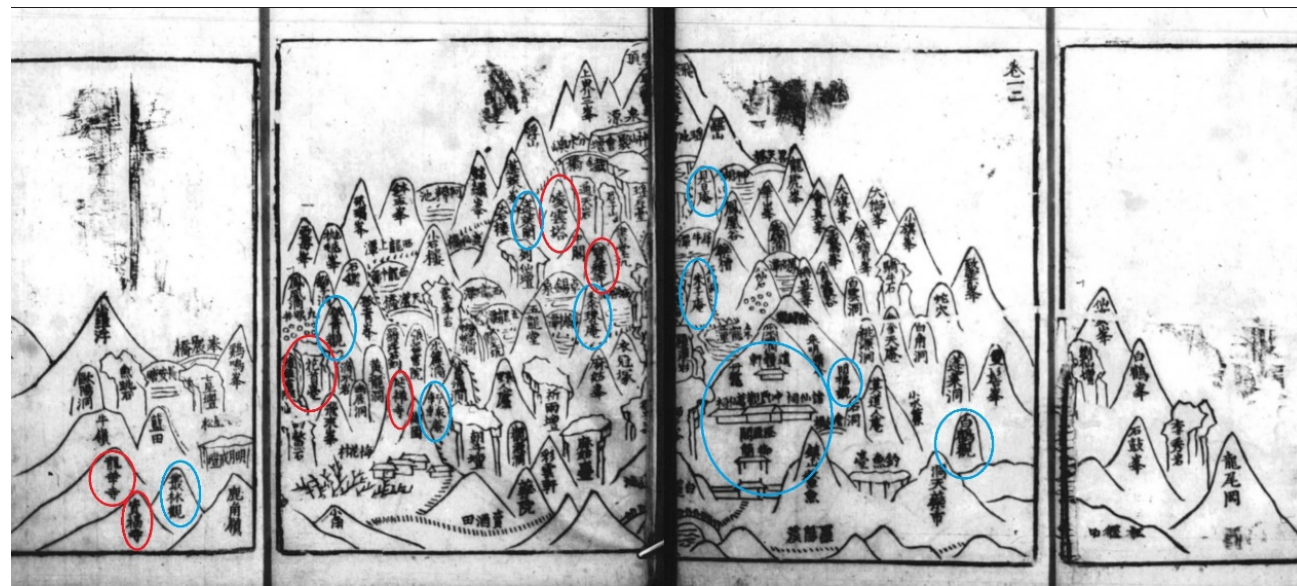
Figure 5. Panorama of the Luofu Mountains in Huang Zuo’s gazetteer, marked with Daoist (blue) and Buddhist (red) sites. Image edited by the author.